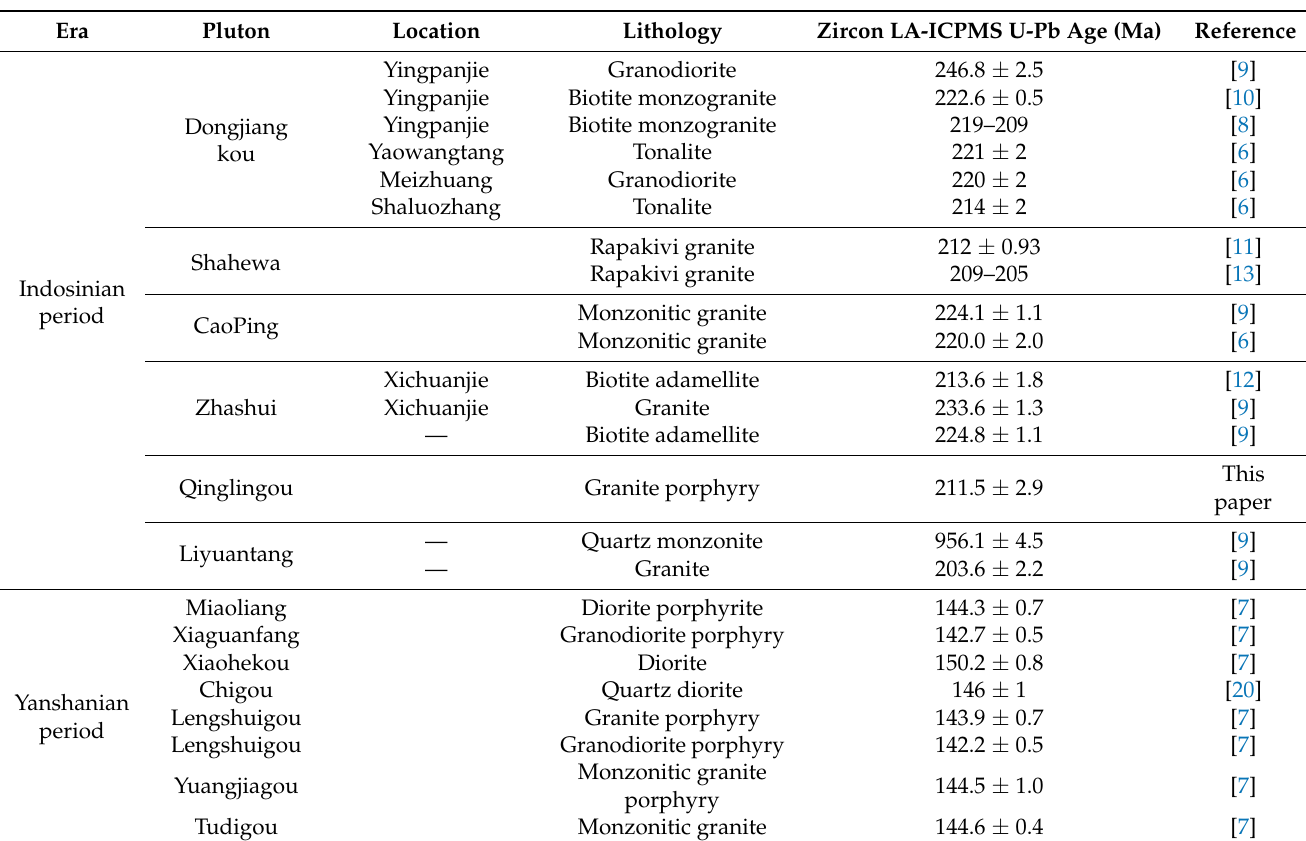
Table 5. Summary intrusion ages of Indosinian Yanshanian Pluton in Zhashui-Shanyang